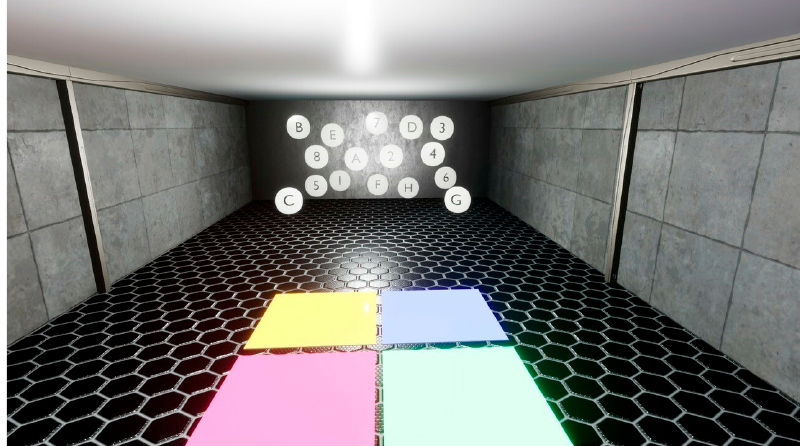
Figure 7. Room no. 4 designed for a scope of dual-task activities.